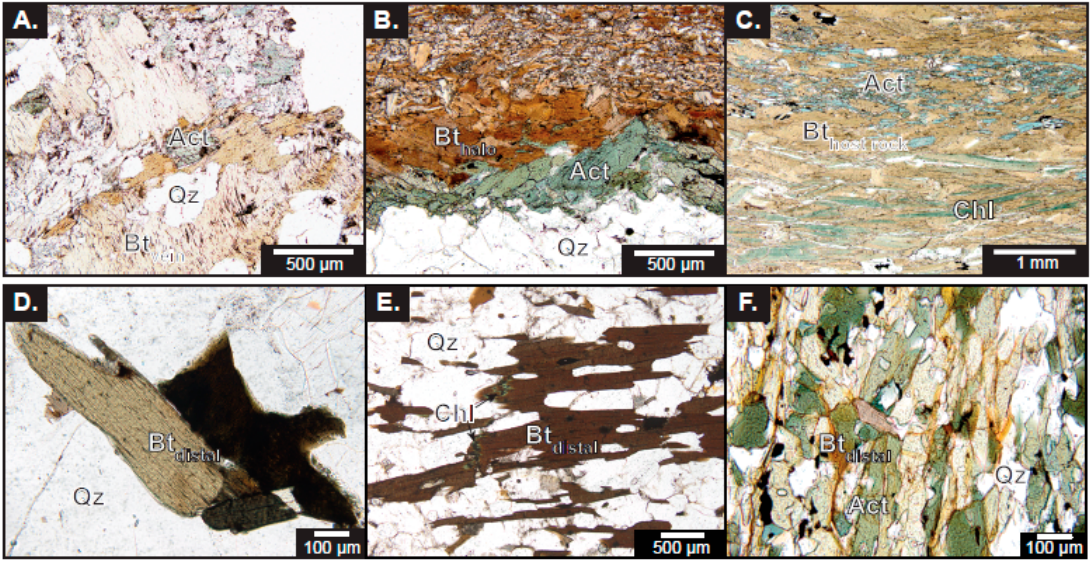
Figure 3. Photomicrographs of the four biotite types of the Detour Lake deposit. ( A ) Very coarse-grained and fine-grained subhedral-euhedral vein biotite in a mineralized pre- to syn-D 2 folded-sulfidized quartz-calcite-chlorite veins (V 5 ; MV-02) intergrown with actinolite. ( B ) Medium-grained, euhedral halo biotite parallel to the pre- to syn-D 2 vein margins (MV-02). Halo biotite are overprinted by actinolite. ( C ) Coarse-grained euhedral host rock biotite from a mineralized biotite schist sample (FW-10). Host rock biotite are overprinted by alternating bands of chlorite and actinolite. ( D ) Cluster of coarse-grained, euhedral barren biotite within the matrix of a barren subgreenschist facies meta-granite (DLR-03). ( E ) Coarse grained, subhedral-euhedral barren biotite defining the main foliation fabric of a barren greenschist facies biotite schist sample (DLR-02) and overgrowing chlorite. ( F ). Very fine grained, anhedral barren biotite aligned with the main foliation fabric in a barren amphibolite facies meta-volcanic sample (WL-01).